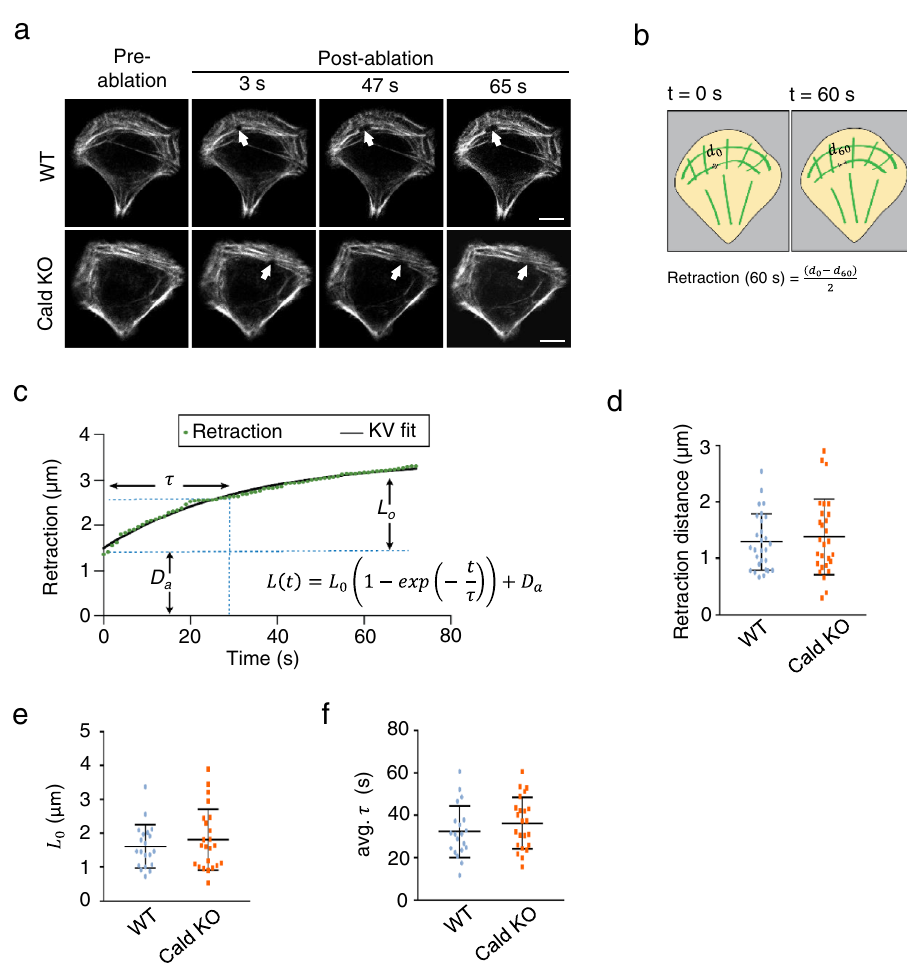
Fig. 5 | Stress fi ber mechanics in wild-type and Caldesmon knockout cells. a Single transverse arc ablation of RFP-LifeAct expressing U20S wild-type and Caldesmonoligo2KOcellsoncrossbowpatterns.Toprowiswild-typeandbottom rowisCaldesmonKO.Cellsat0sillustratethedistributionofSFspre-ablation,and cellsat3sillustratethedistributionofSFsimmediatelyafterablation.Whitearrows highlighttheincreaseinretractionofthestress fi berpost-ablationat3,45,and65s from the start of imaging. Scale bars=10 µ m. b Schematic of SF retraction mea- surement and model-independent SF retraction calculation. c Example of SF retraction tracked over time. The retraction distance is the half-distance between the severed ends at time t . The SF retraction is fi tted to the Kelvin – Voigt model to extract plateau retraction distance ( L 0 ), viscoelastic constant ( τ ), and the length of the SF destroyed during photoablation ( D a ) (see the “ Methods ” section). d Model-